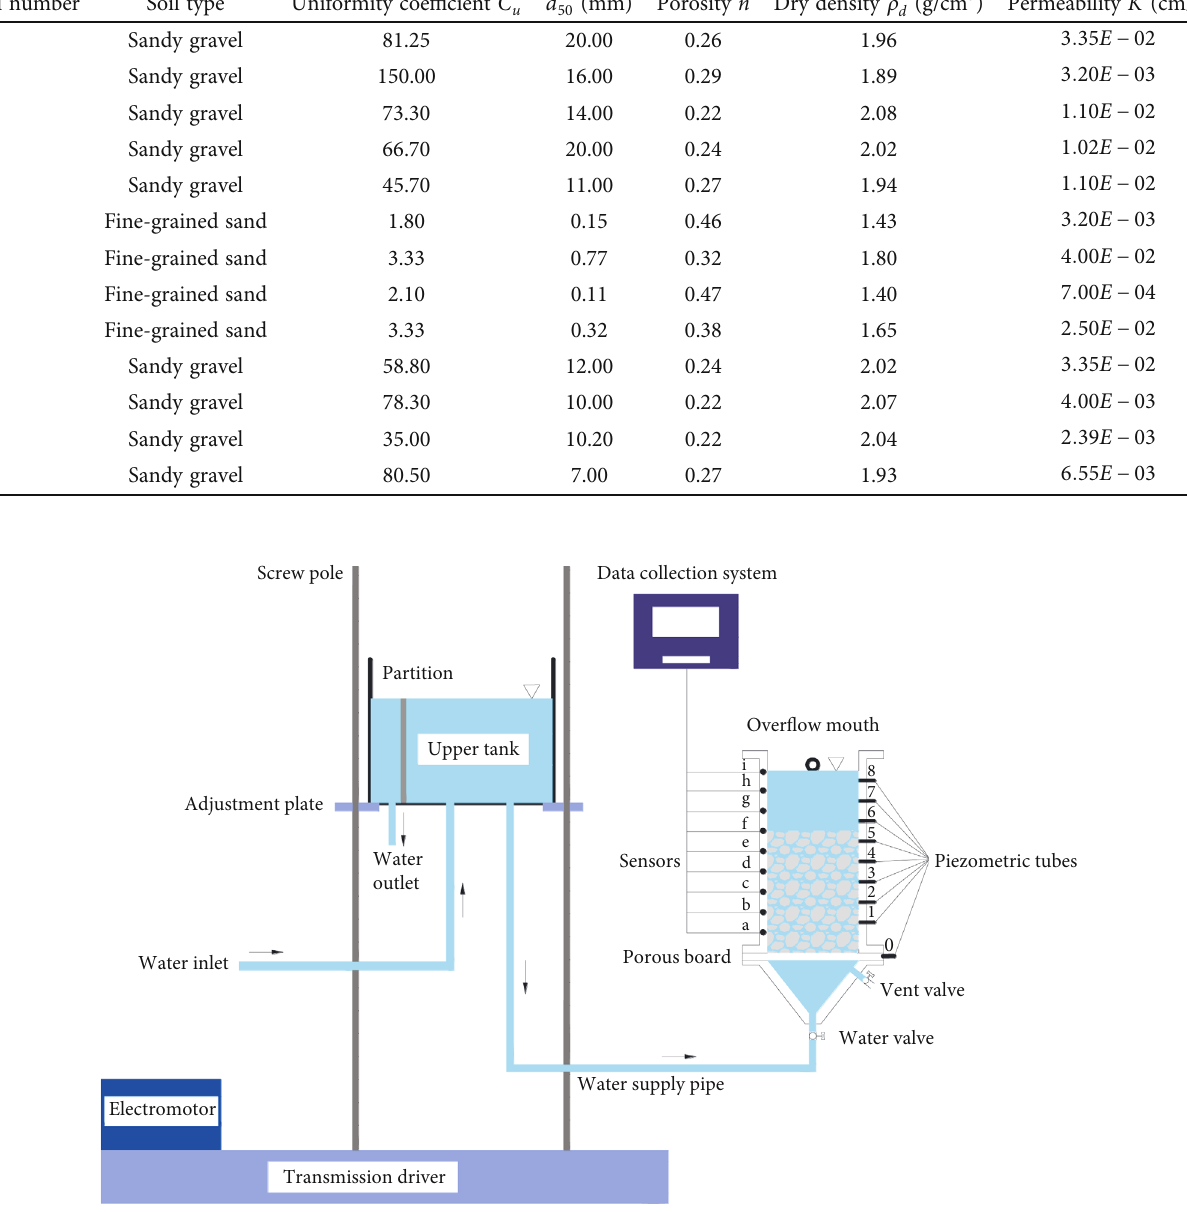
Figure 4: Schematic illustration of testing